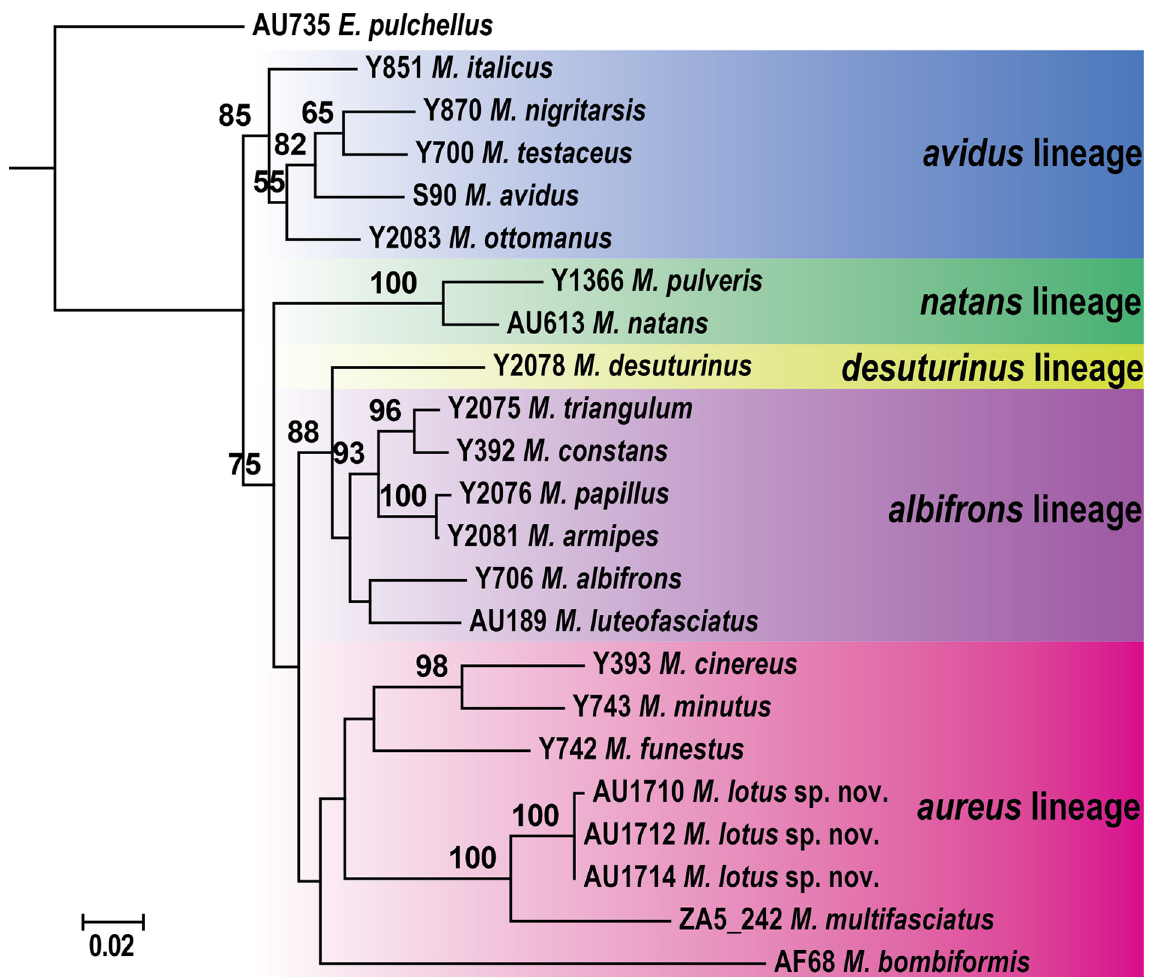
Fig. 27. Maximum likelihood tree from the concatenated data set with COI, 28S and 18S rRNA gene